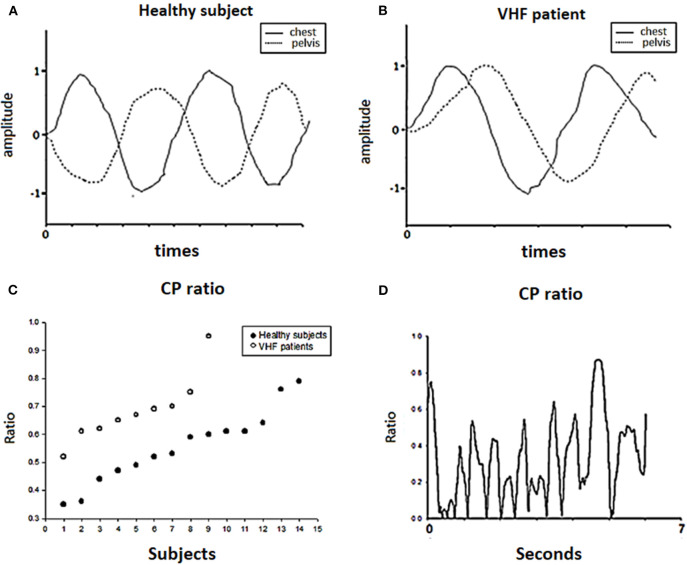
Chest-pelvis ratio (CP ratio). The angular data of the chest (C) and pelvis (P) were normalized by the maximal degrees of chest and pelvic rotation, respectively, as shown in (A,B). Then, we calculated the CP ratio as the ratio of the maximal rotation in degrees and of the chest and pelvis. In (C), each dot represents the chest-pelvis ratio (CP ratio) of each subject during the forward walking trial. Patients had higher CP ratio on average than healthy subjects. (D) Shows the change in the CP ratio among the trials for one patient.